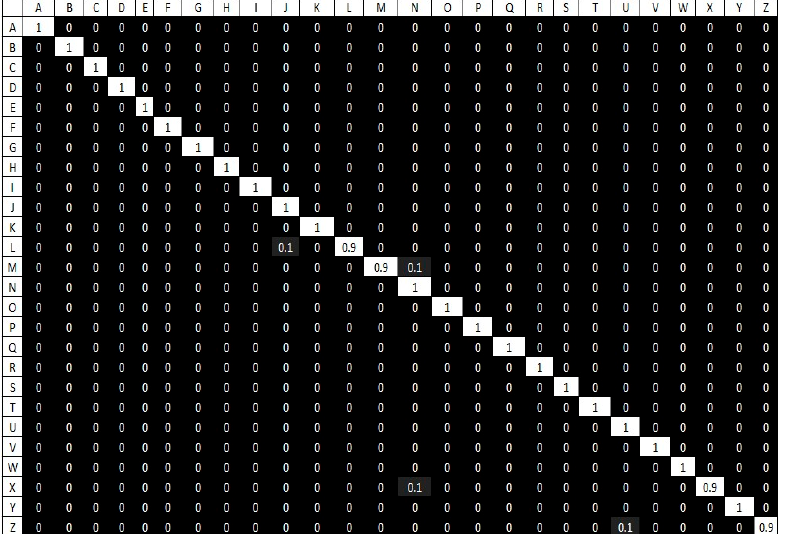
Figure 13. Confusion matrix of letters A to Z.